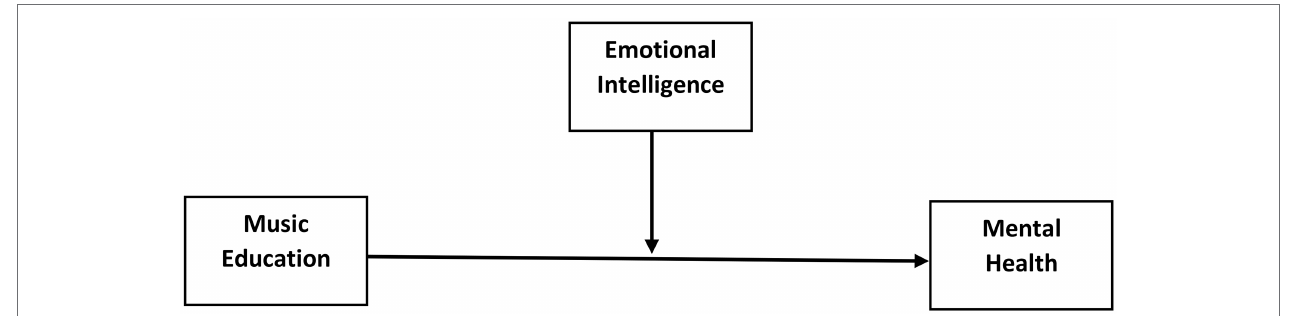
FIGURE 1 | Conceptual